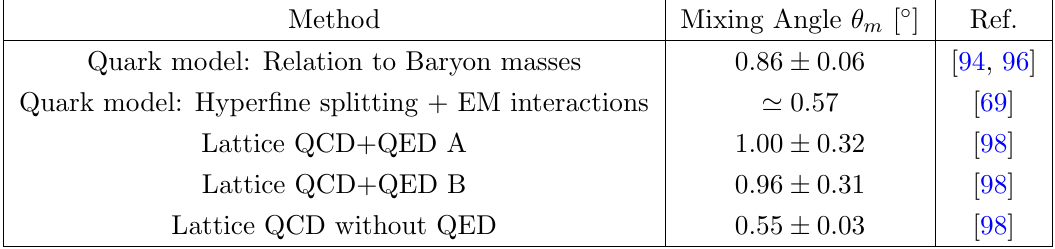
Table 8. Results for the (cid:6) 0 {(cid:3) mixing angle. Note that we adjusted the sign conventions for the results to match always the one of ref. [94], see also the corresponding comment in ref. [98]. For older lattice results for the \QCD only" scenario see refs. [95, 97]. Note that with alternate quark mass input taken from ref. [129] the result for the \Lattice QCD without QED" scenario is changed to (cid:18) m = 0 : 65 (cid:6) 0 : 03